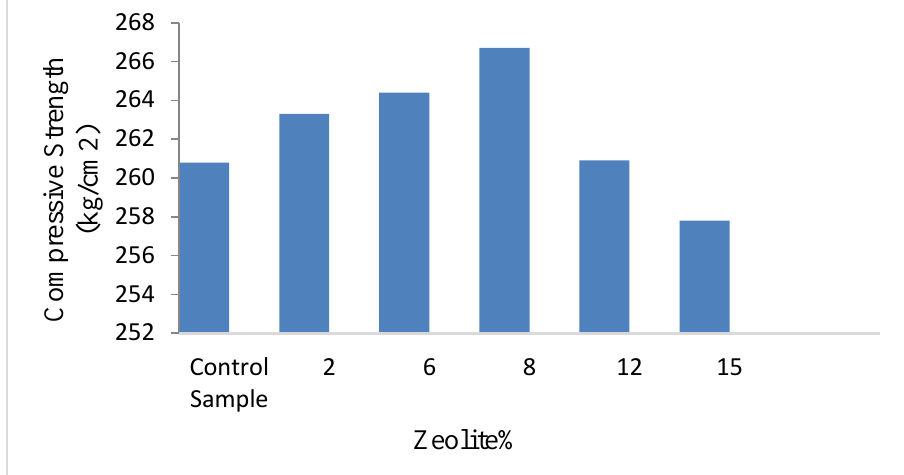
Fig. 6. Concrete strength with different percentages of Zeolite with 380 grade cement at 28 days old